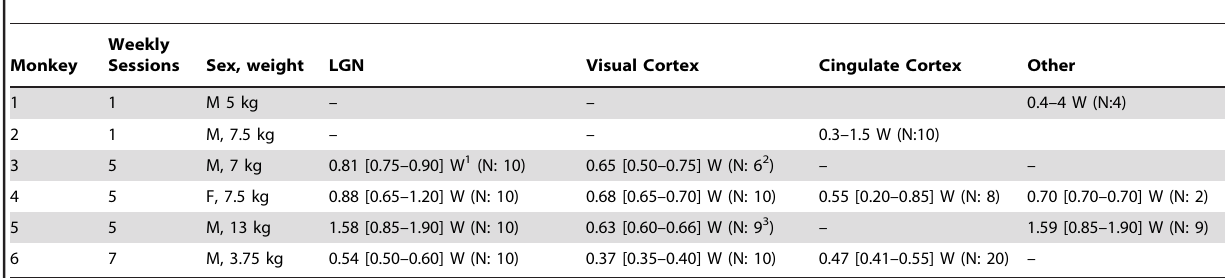
Table 1. Acoustic power level used at the different targeted structures in each animal.